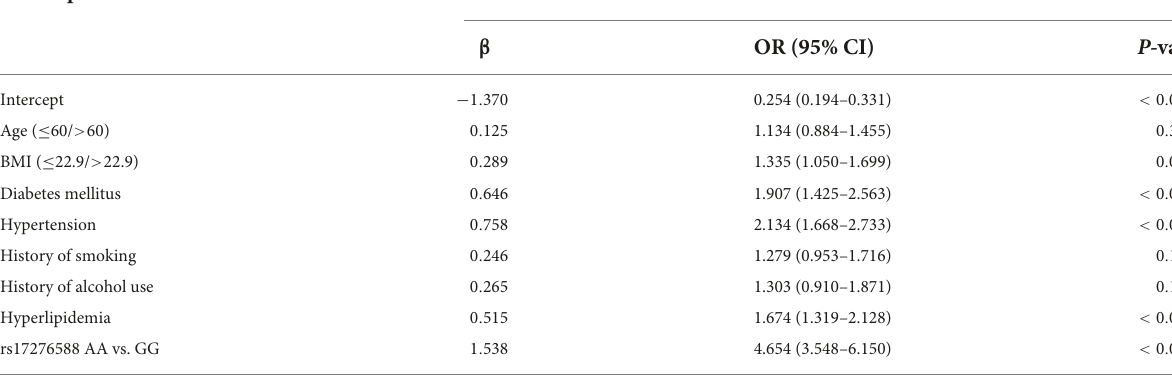
TABLE 4A Multivariate logistic regression analysis for the ischemic stroke (IS) risk factors among the male population. Intercept and variables